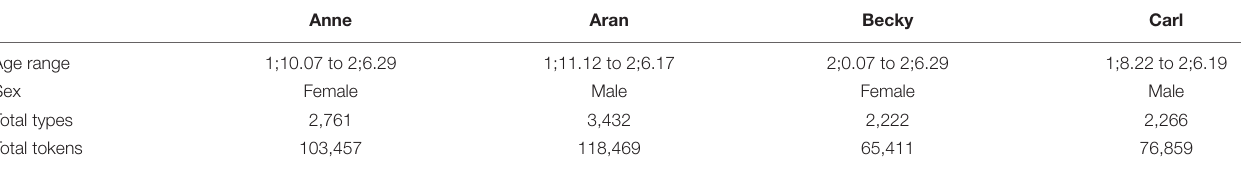
TABLE 1 | Characteristics of the selected corpora. Anne Aran Becky